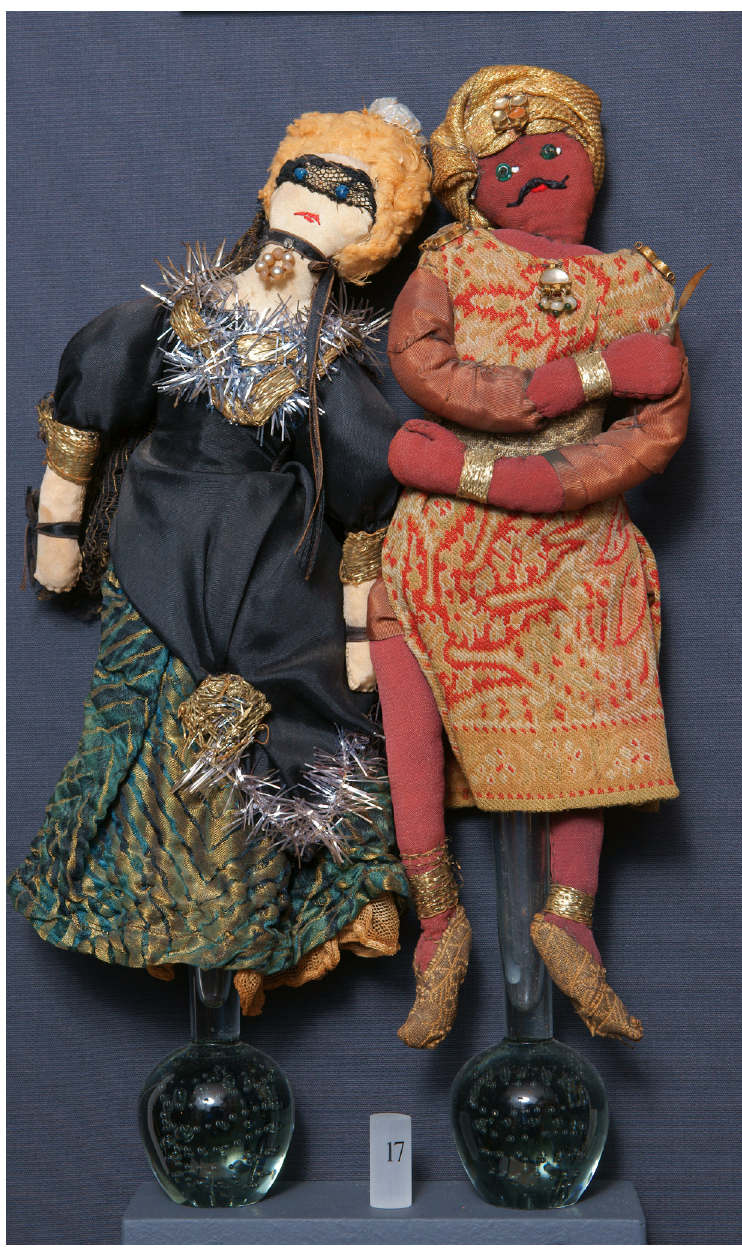
Figure 1.3 Two dolls made for Betty Pinney by Sylvia Townsend Warner. Courtesy of Dorset County